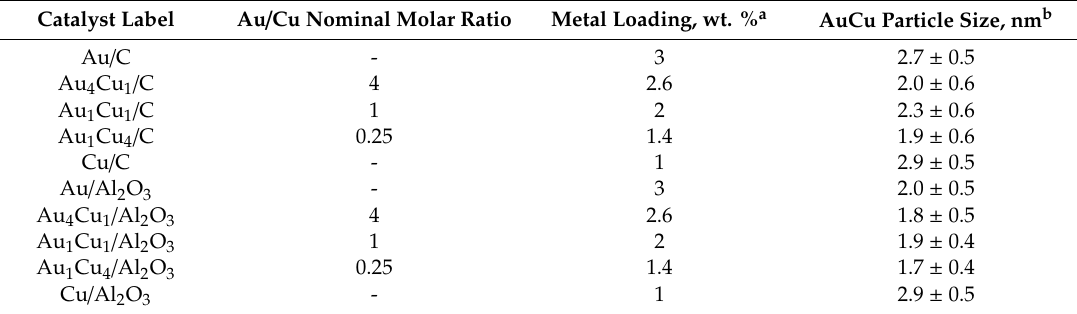
Table 4. Catalysts list, total metal loadings (wt. %) and Au / Cu theoretical molar ratio. Catalyst